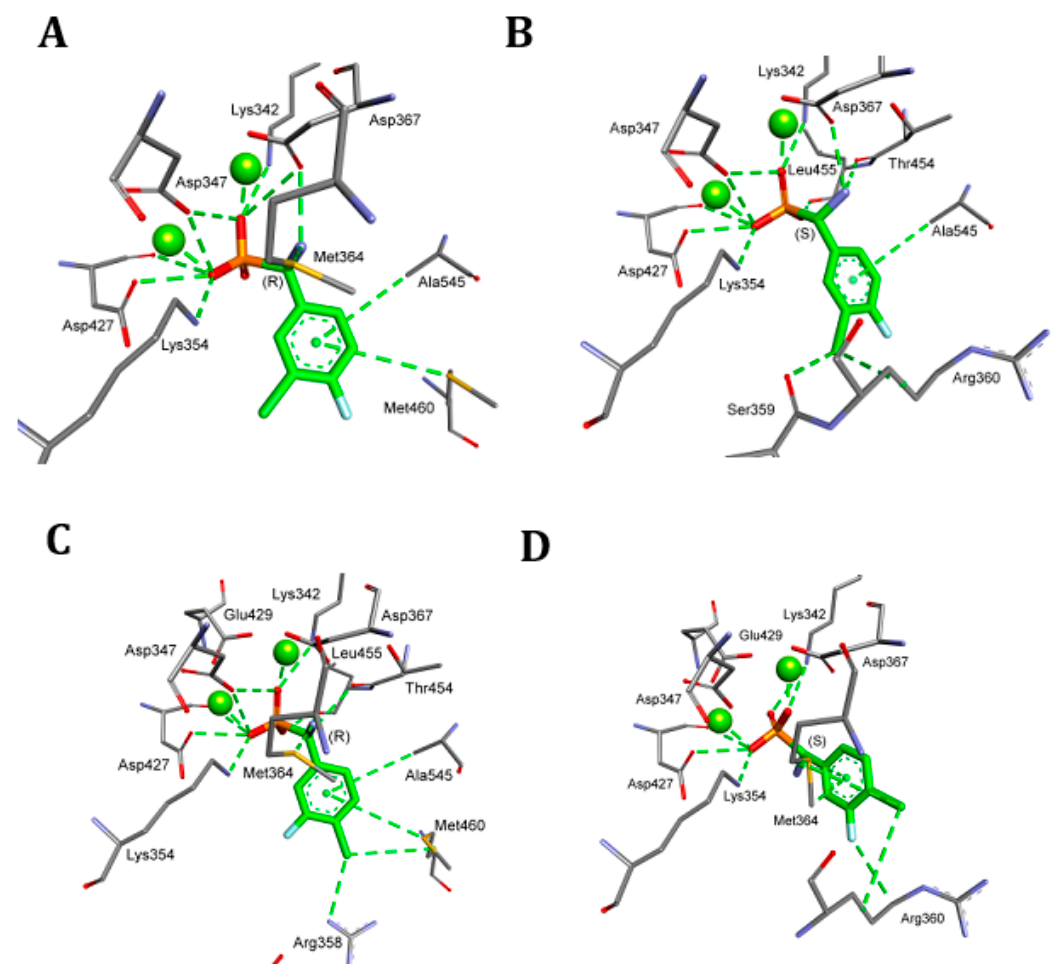
Figure 6. Mode of binding of both enantiomers of compounds 7 and 8 by tomato leucine aminopeptidase. A : S -isomer, B : R -isomer of compound 7 , C : S -isomer, D : R -isomer of compound 8 .